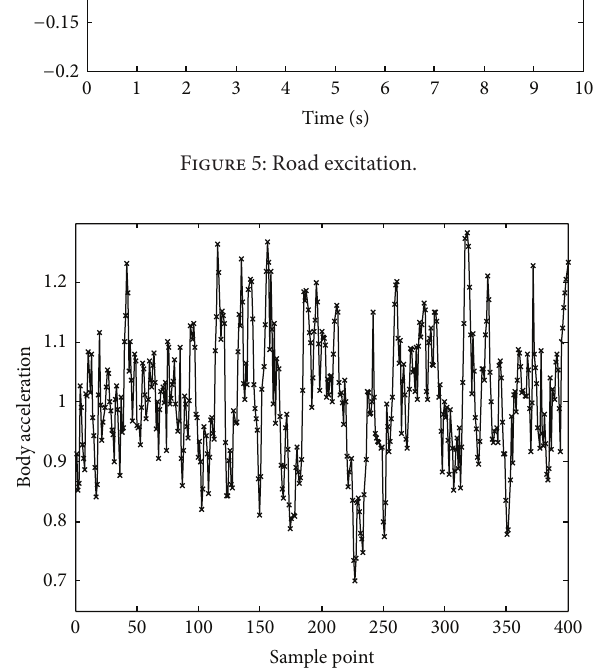
Figure 6: Training result.